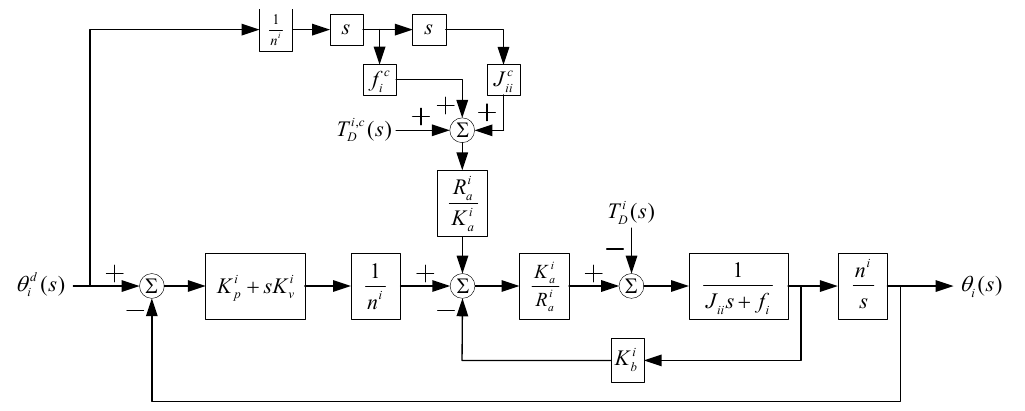
Figure 1. Proportional-plus-derivative (PD) control scheme of a robot joint, i